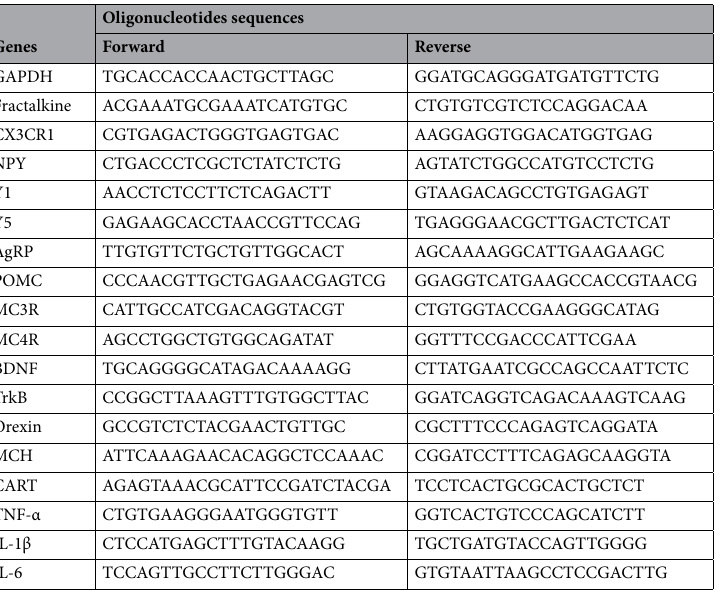
Table 1. Primers used for RT-PCR. GAPDH Glyceraldehyde-3-phosphate dehydrogenase, NPY Neuropeptide Y, AgRP Agouti-related protein, POMC Proopiomelanocortin, MC3R Melanocortin-3, MC4R Melanocortin-4 receptors, BDNF Brain-derived neurotrophic factor, MCH Melanin-concentrating hormone, CART Cocaine- and amphetamine-regulated transcript peptide, TNF-α Tumour necrosis factor-α, IL-1β Interleukin-1β, IL-6